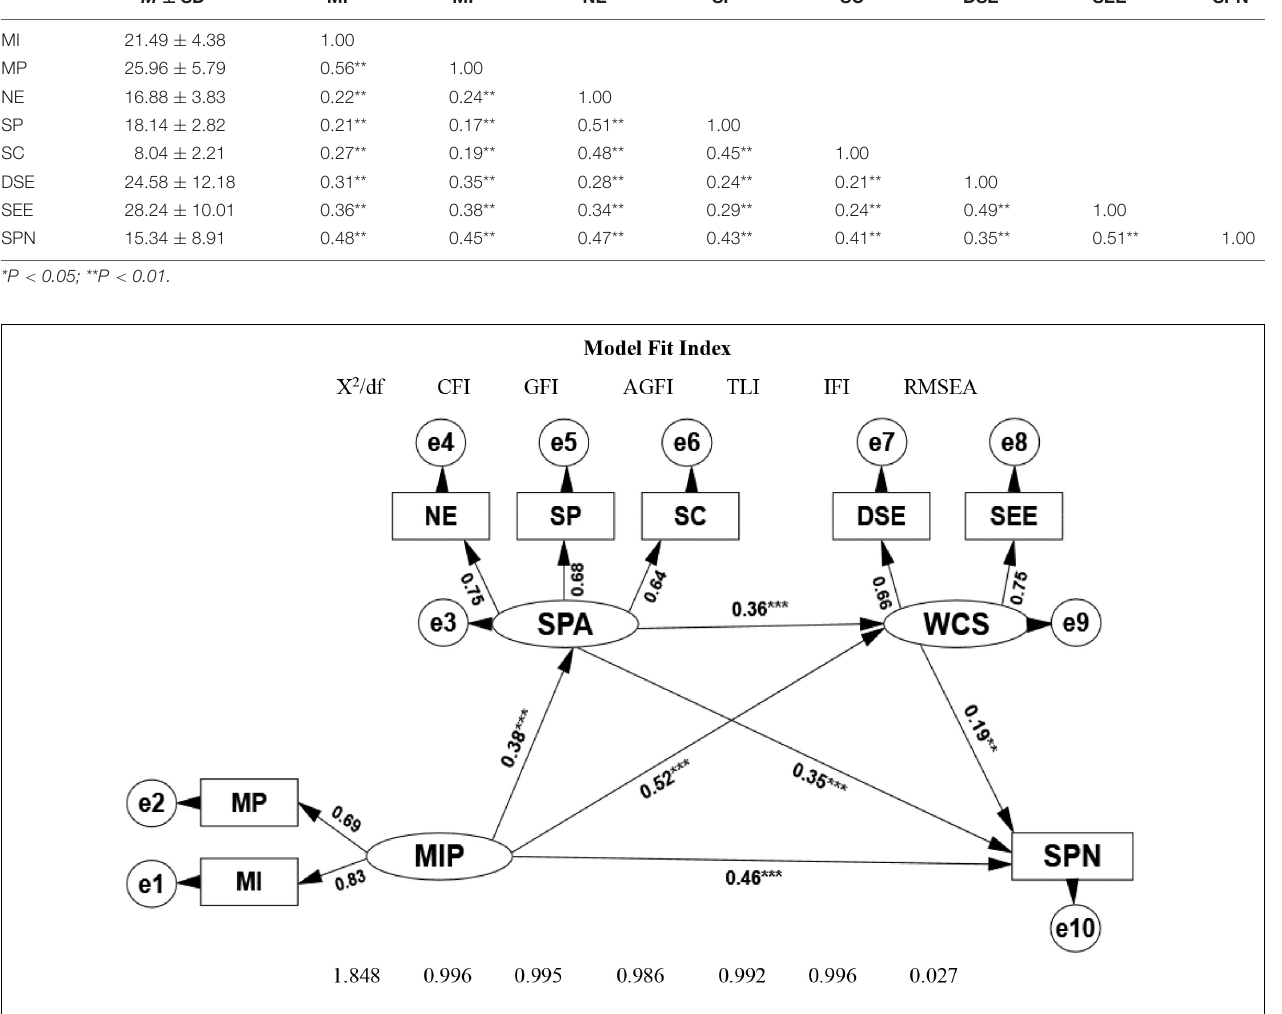
FIGURE 1 | Path analysis diagram and model fit test of media internalized pressure, social physique anxiety, weight control self-efficacy, and sports participation. MIP, media internalized pressure; SPA, social physique anxiety; WCS, weight control self-efficacy; SP, sports participation; MP, media pressure; MI,